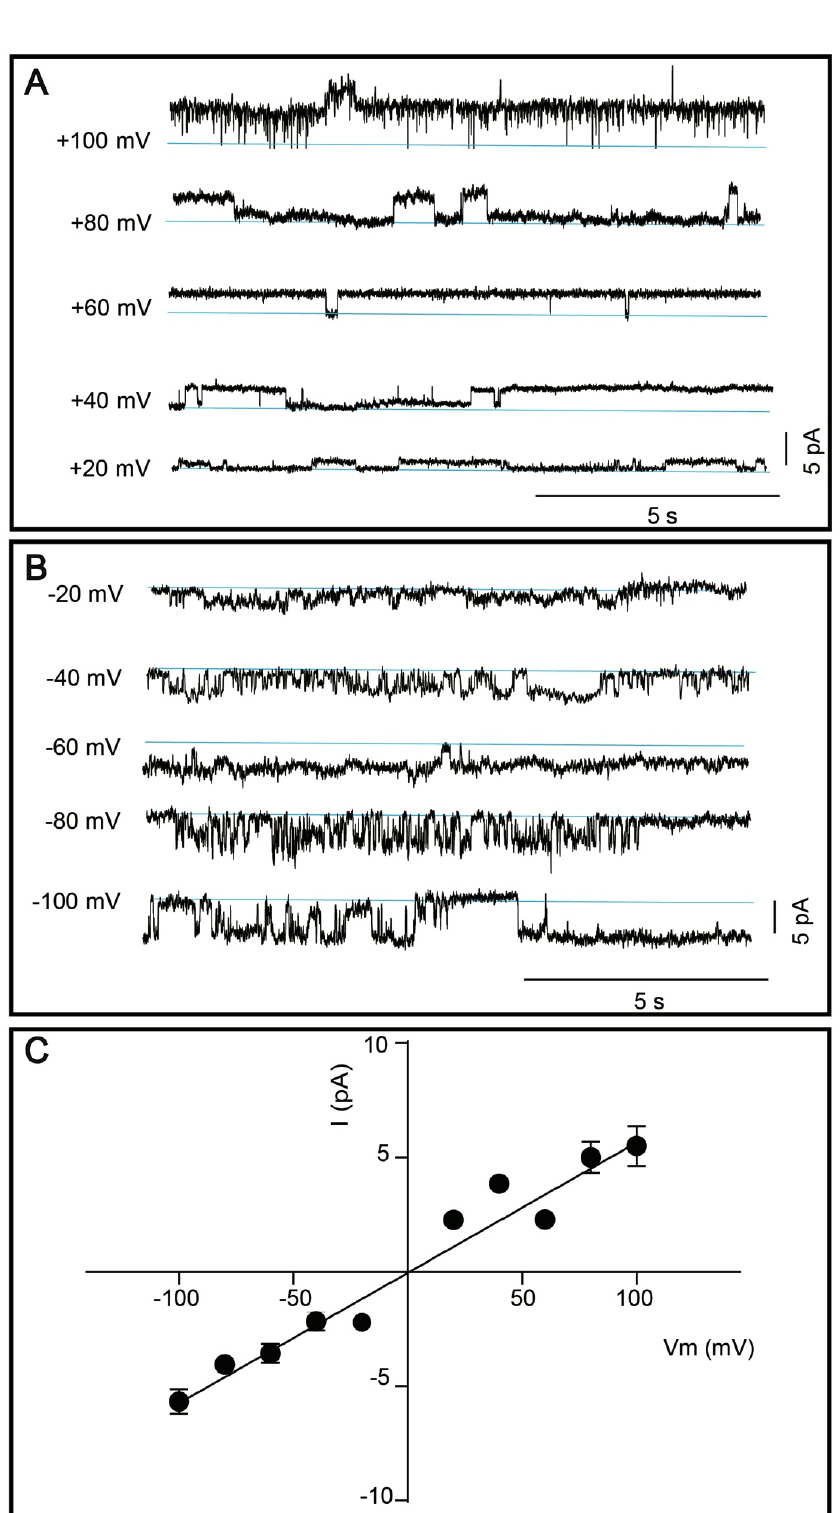
Figure 7. Single channel activity of affinity and size-exclusion chromatography purified TRPM8. ( A – B ) Representative single channel currents of TRPM8 reconstituted in the planar lipid bilayer membranes. Currents were elicited by positive ( A ) and negative ( B ) voltage steps. Channel activity is observed at all applied voltages. Zero current is indicated by the blue lines. ( C ) Current (I) was plotted as a function of voltage (V) and a linear regression was fitted to the data to determine the slope conductance (56.9 ± 3.2 pS). Results are shown as mean ± SEM, each data point was based on 2–52 single channel